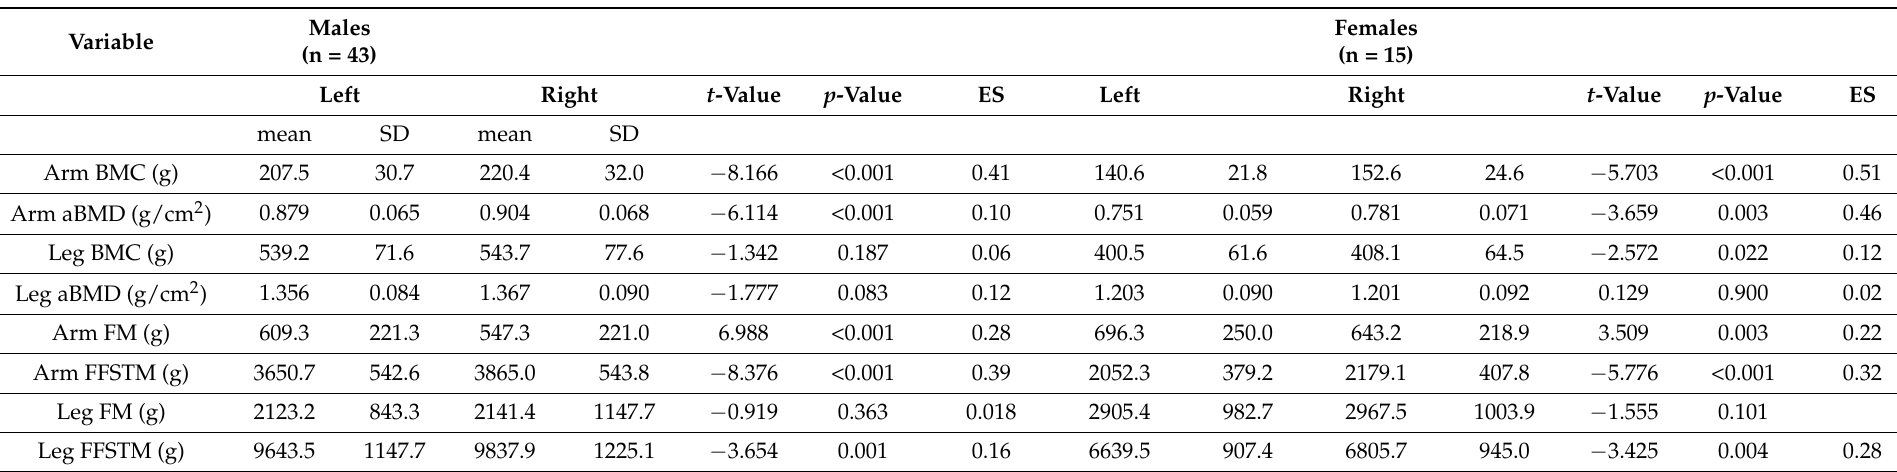
Table 6. Asymmetry in limb body composition for the whole sample of karatekas (n = 58). Student’s t